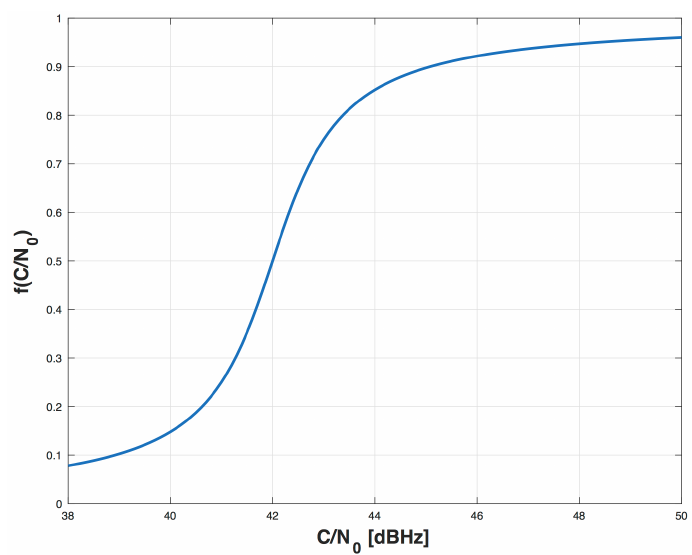
Figure 9. Example of trend of f function with a = 42